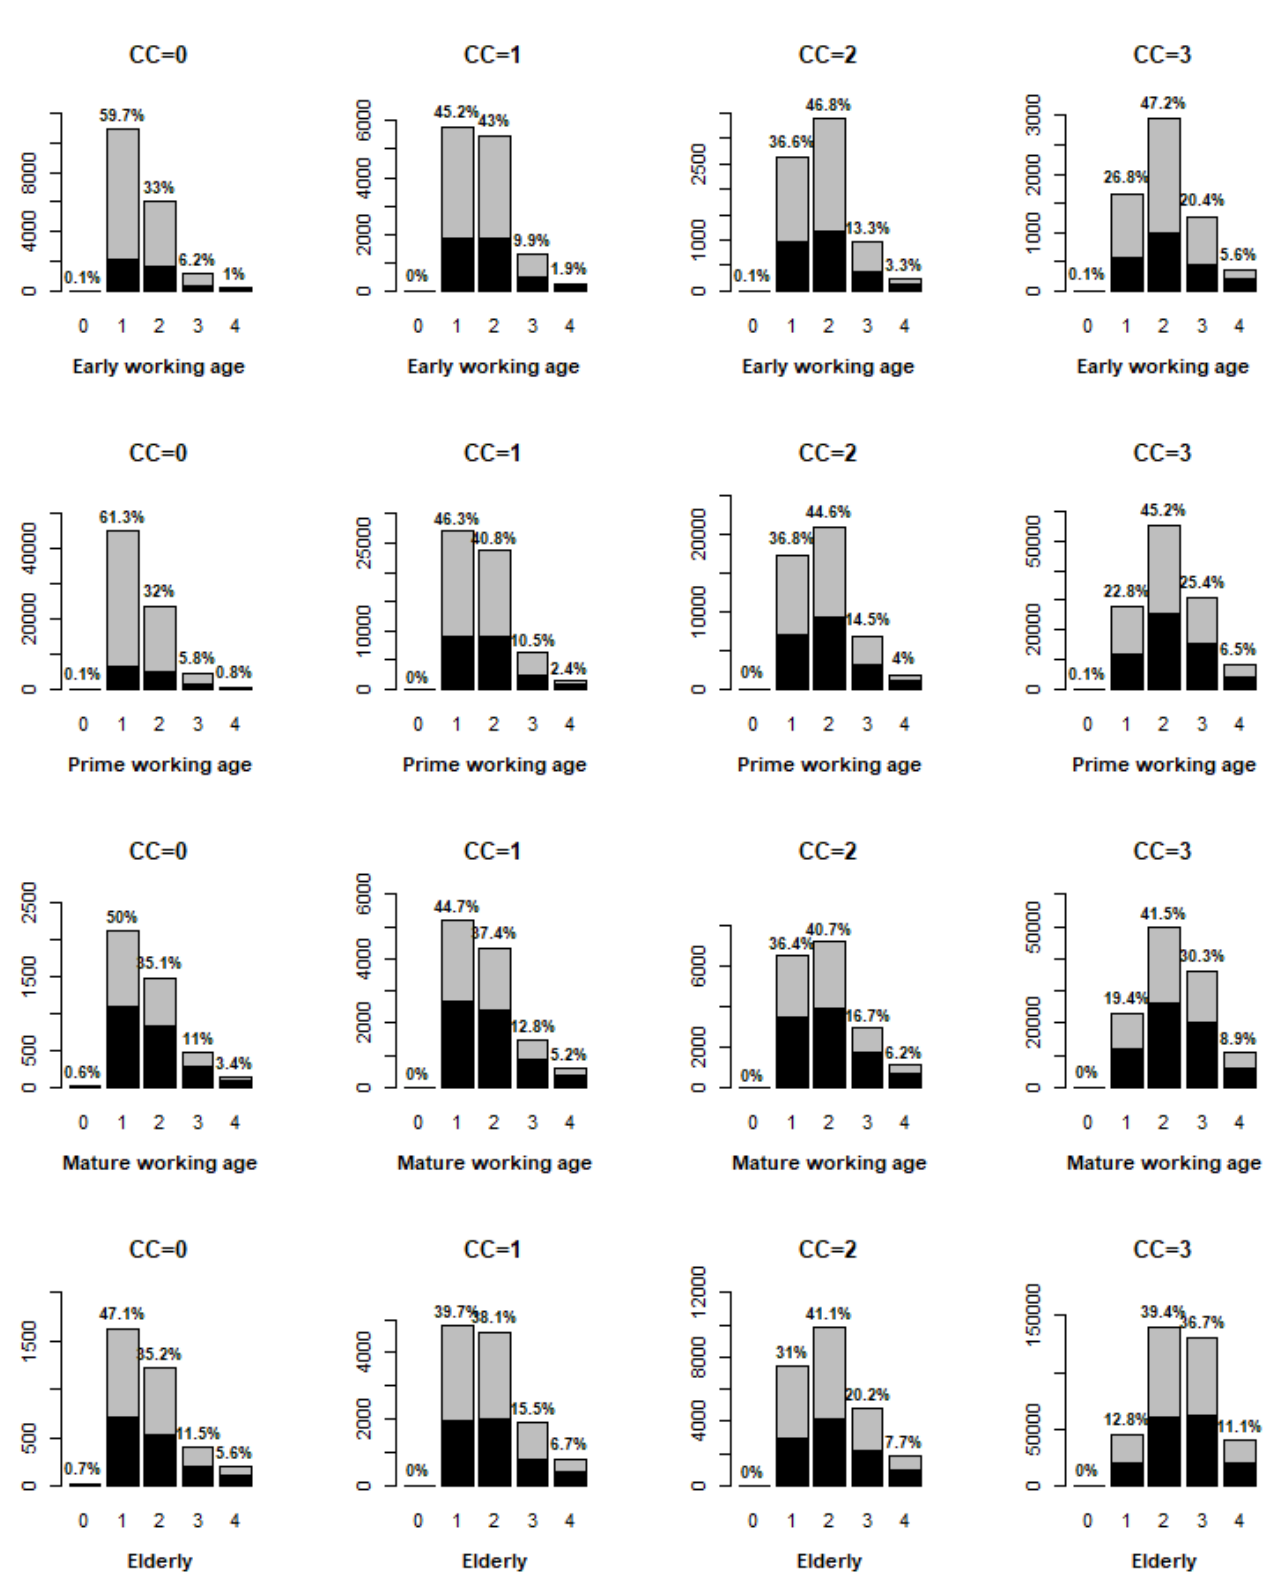
Figure A2. SOI and differences in patients’ characteristics among demographic factors and CC. The black is for male and grey is for female. Table A1. Predicted probabilities corresponding to patient characteristics and ROM and SOI levels. The mean value (with its standard error) is reported, (calculation unit: %).